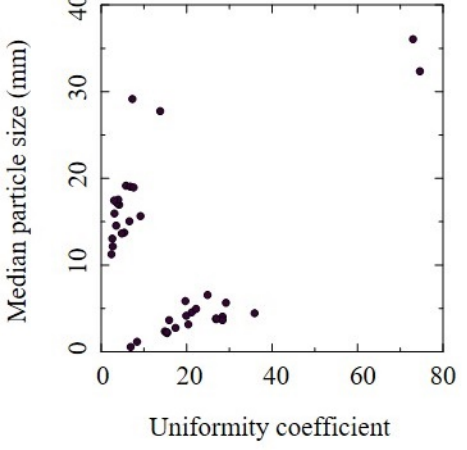
Figure 6. Relationship between median particle size and uniformity coefficient.